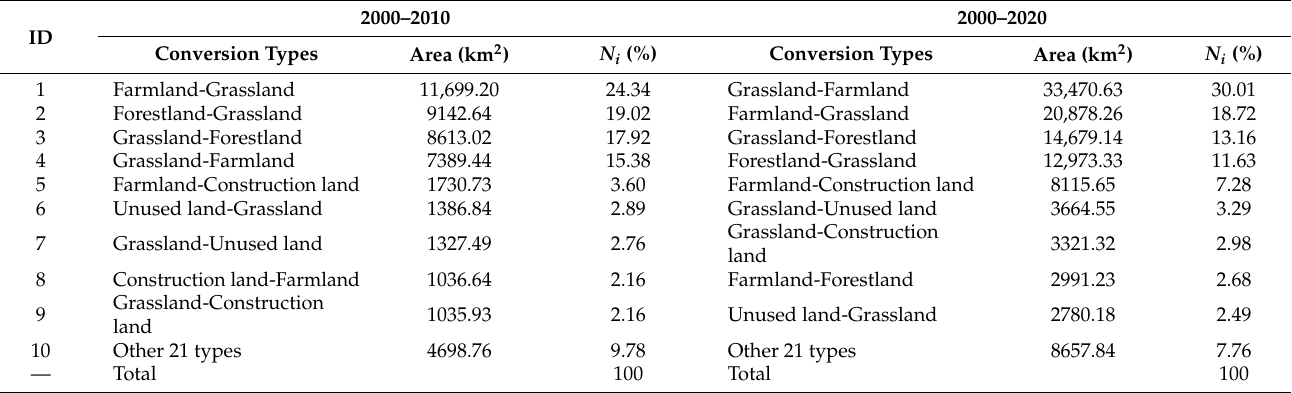
Table 6. Importance index of land-use changes in the AENC during